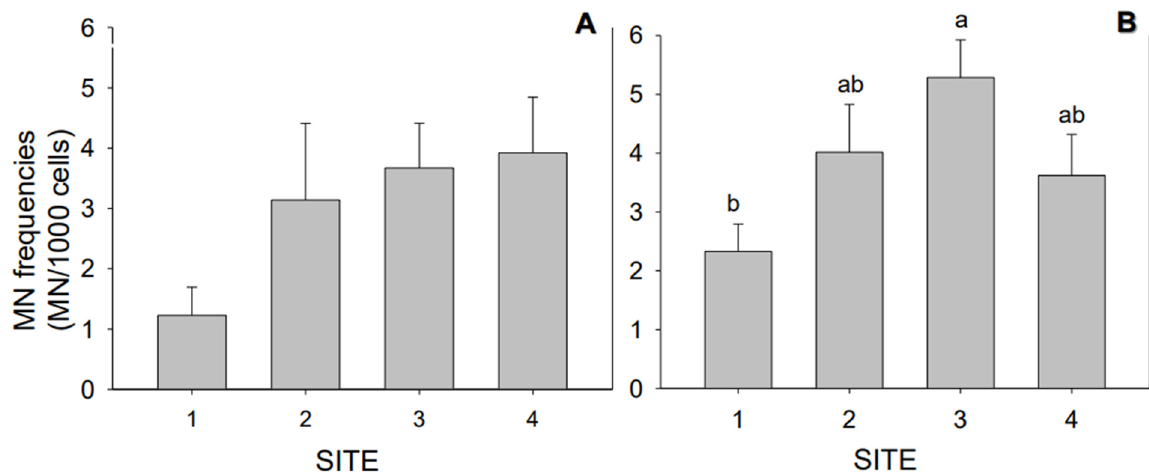
Figure 4. Cytological endpoint measured in Jenynsia multidentata collected at the four study sites (S1 to S4), as micronucleus (MN) induction in the dry ( A ) and wet ( B ) seasons. Different letters indicate statistical differences among sampling sites ( p < 0.05). The whiskers represent the ± SEM.